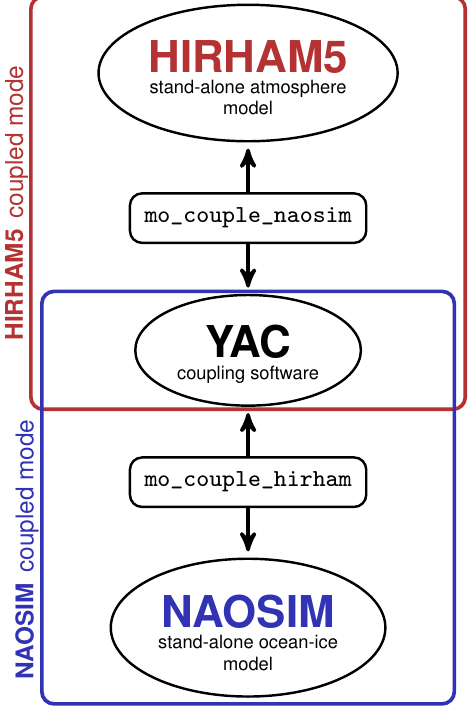
Figure 2. Schematic diagram of the coupling of HIRHAM5 and NAOSIM using the coupling software YAC (Yet Another Coupler). The boxes “mo_couple_naosim” and “mo_couple_hirham” represent the interface modules between the two model components and